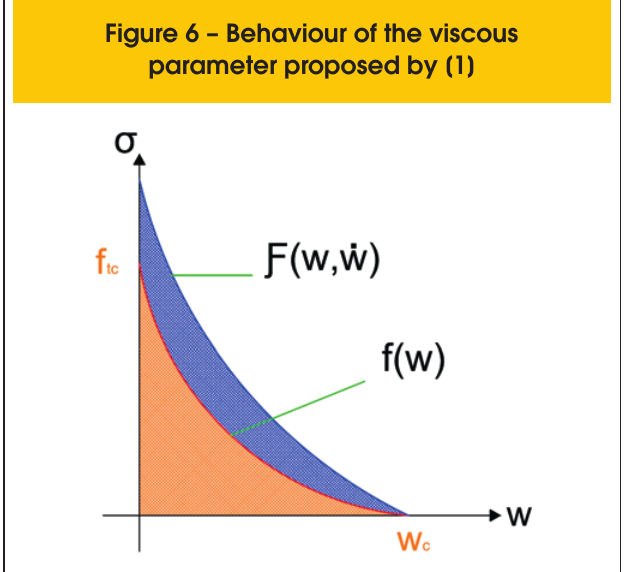
Figure 6 – Behaviour of the viscous parameter proposed by [1]